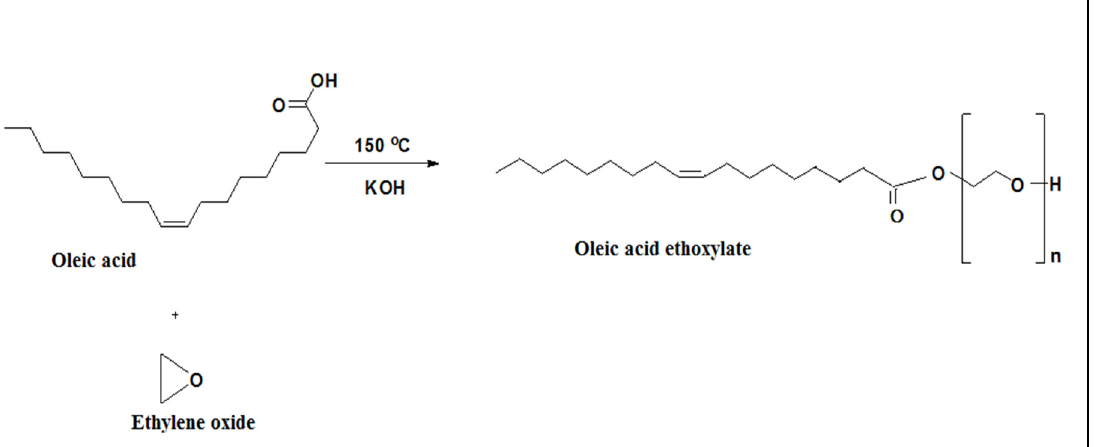
Figure 1. Batch laboratory-scale unit for ethoxylation reaction.